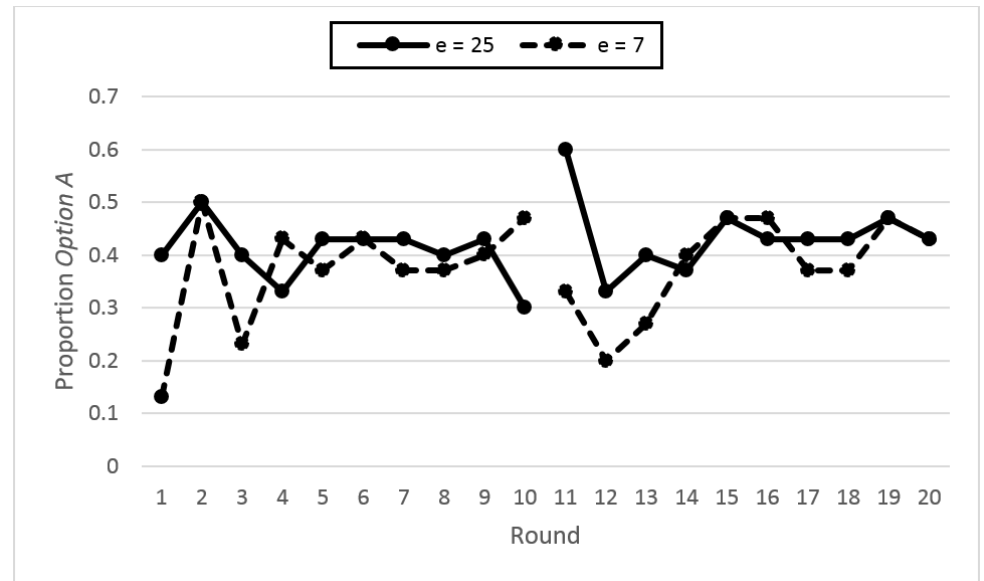
Figure 1. Proportion “ Option A ” by round and endowment level.